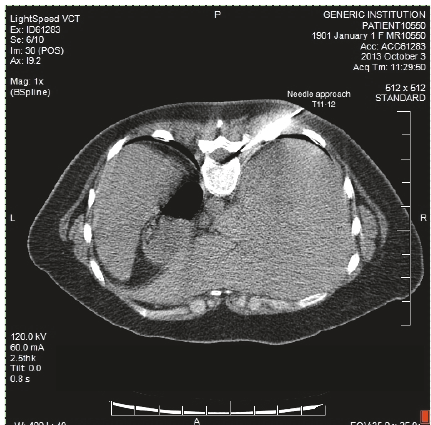
Figure 2: CT-guided image displaying the Tuohy needle trajectory to achieve right-sided transforaminal epidural placement for the injection of hydrogel sealant.